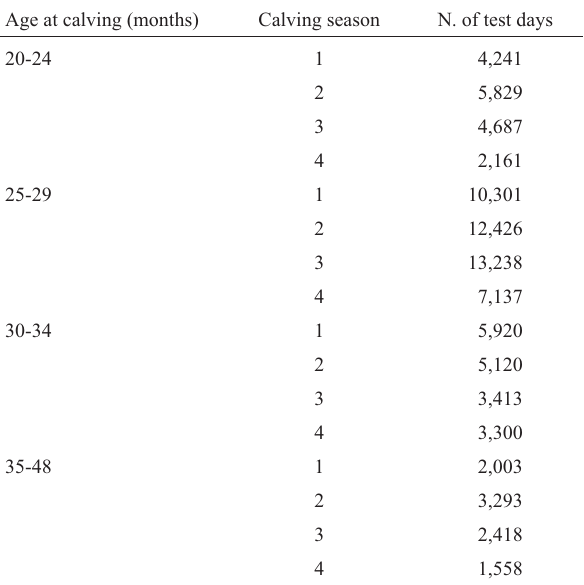
Table 2 - Number of test days per class of cow’s age and calving season after data